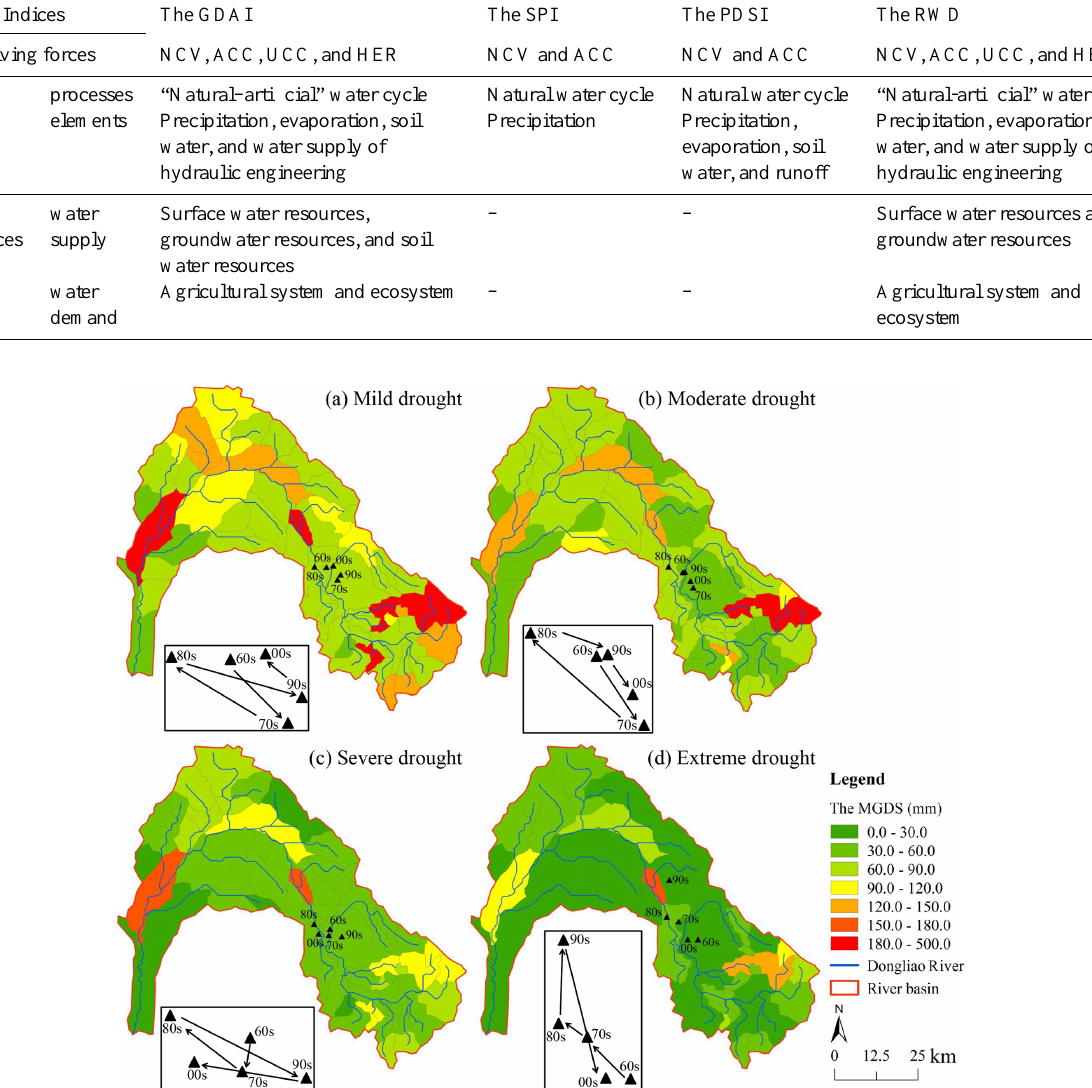
Figure 6. Spatial distribution of the MGDS of different drought levels in various